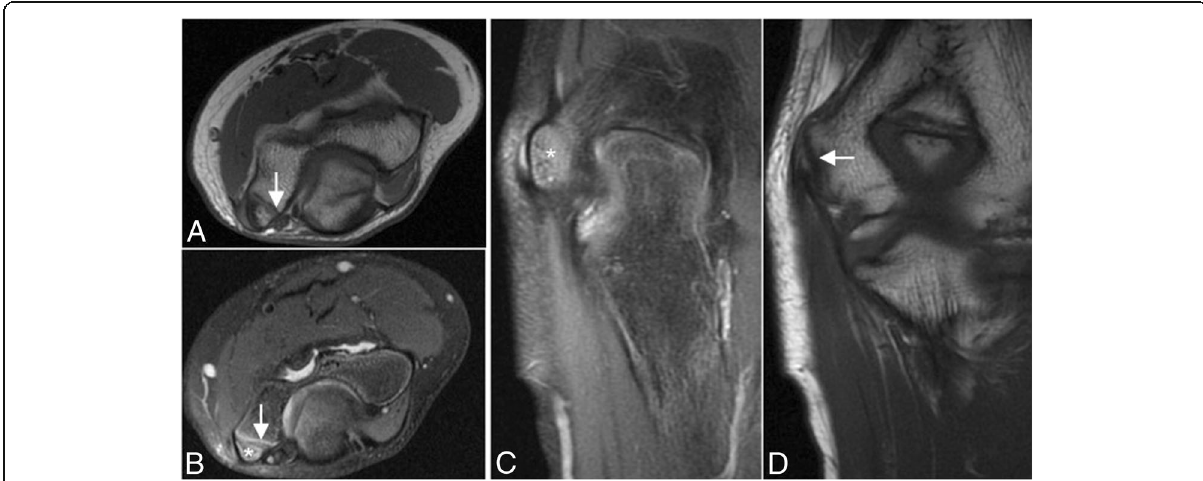
Fig. 20 A 12-year-old left-handed baseball pitcher with medial epicondyle pain. Axial T1-weighted MRI ( a ), axial FS PD-weighted MRI ( b ), coronal